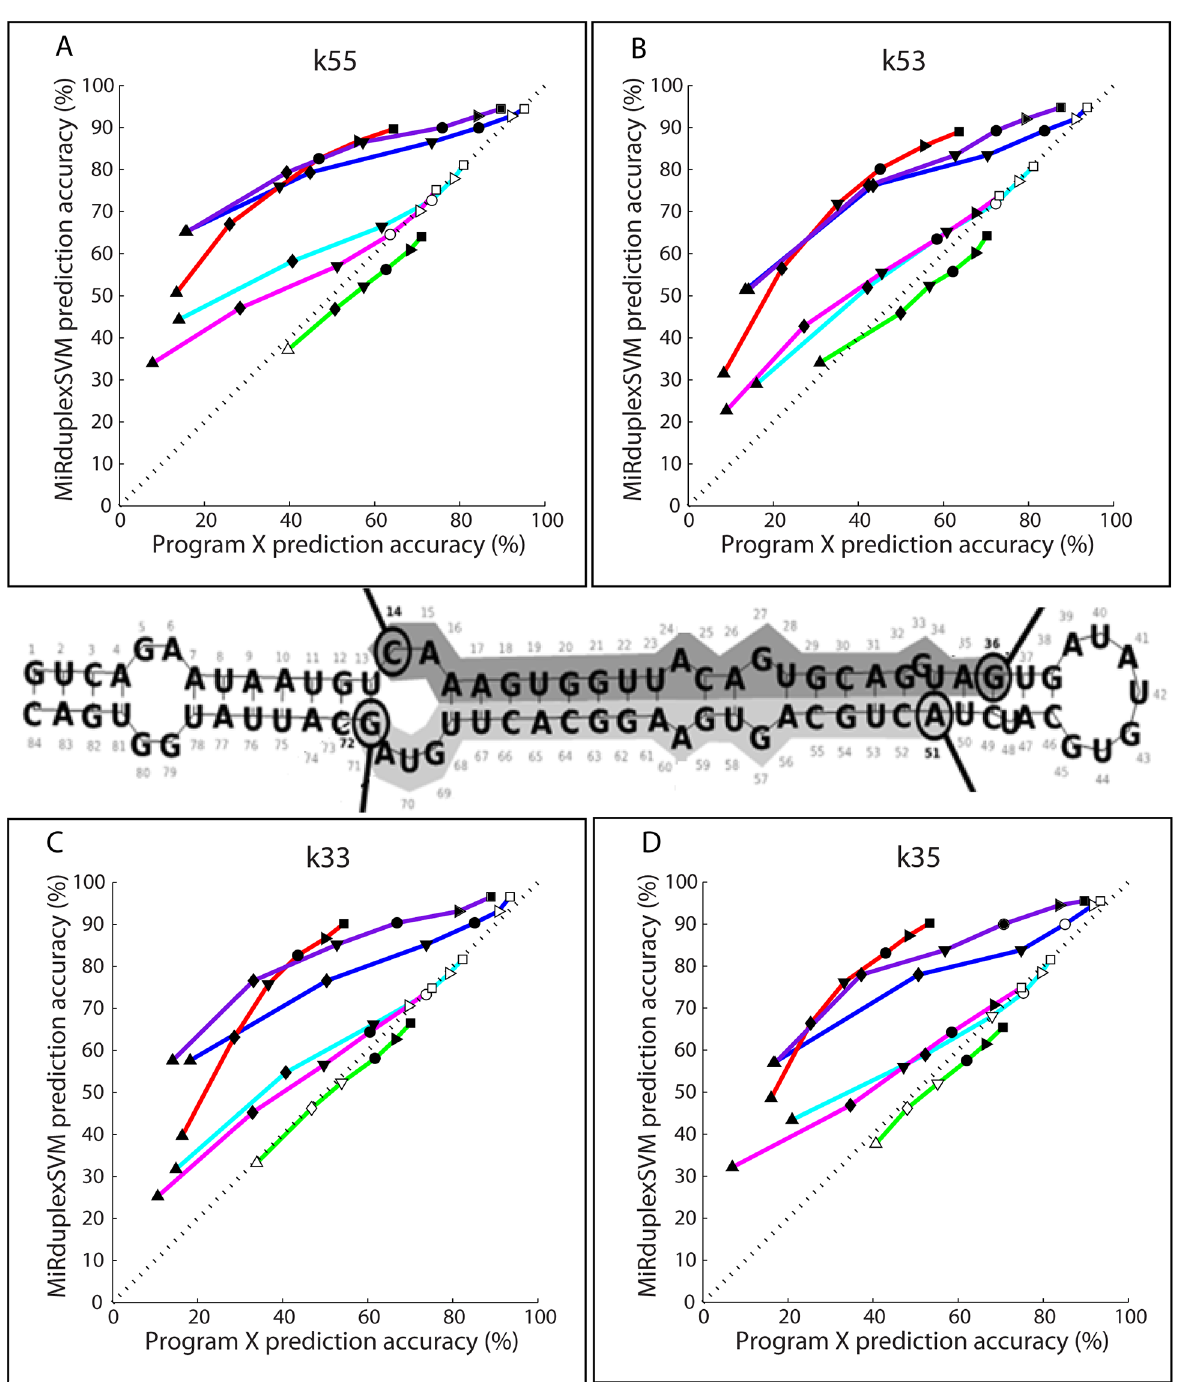
Fig 4. Prediction accuracy of MiRduplexSVM versus six other methods on corner identification. Performance accuracies are estimated using the EAE for errors of 0-5nts. In each panel, the y axis shows the prediction accuracy of MiRduplexSVM (in %) and the x axis shows the prediction accuracy of other methods (in %). The colour and symbol scheme is the same as in Fig 3G. Statistically significant results are indicated with filled symbols.